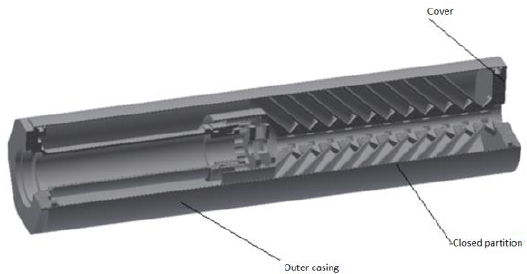
Figure 5. Second reactive silencer configuration.